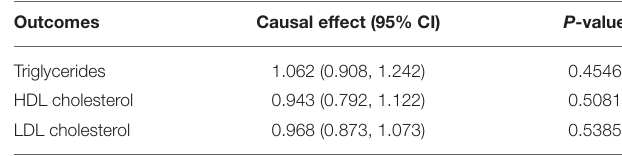
TABLE 2 | Causal effects between genetic predisposition toward common risk factors of endometrial cancer and circulating plasma vitamin C.